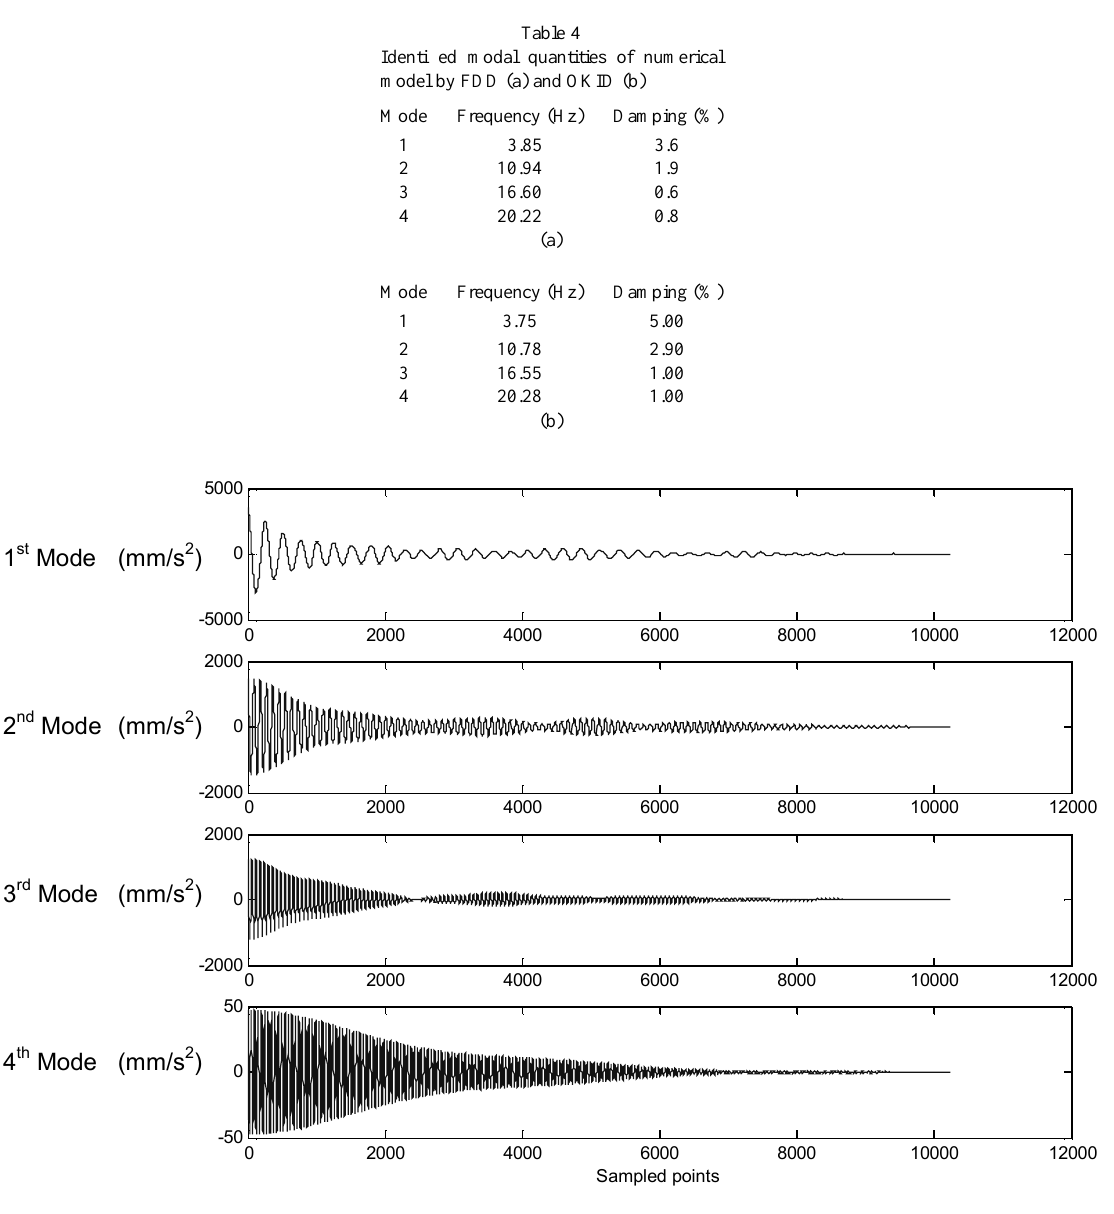
Fig. 5. Time-domain SDOF decay histories